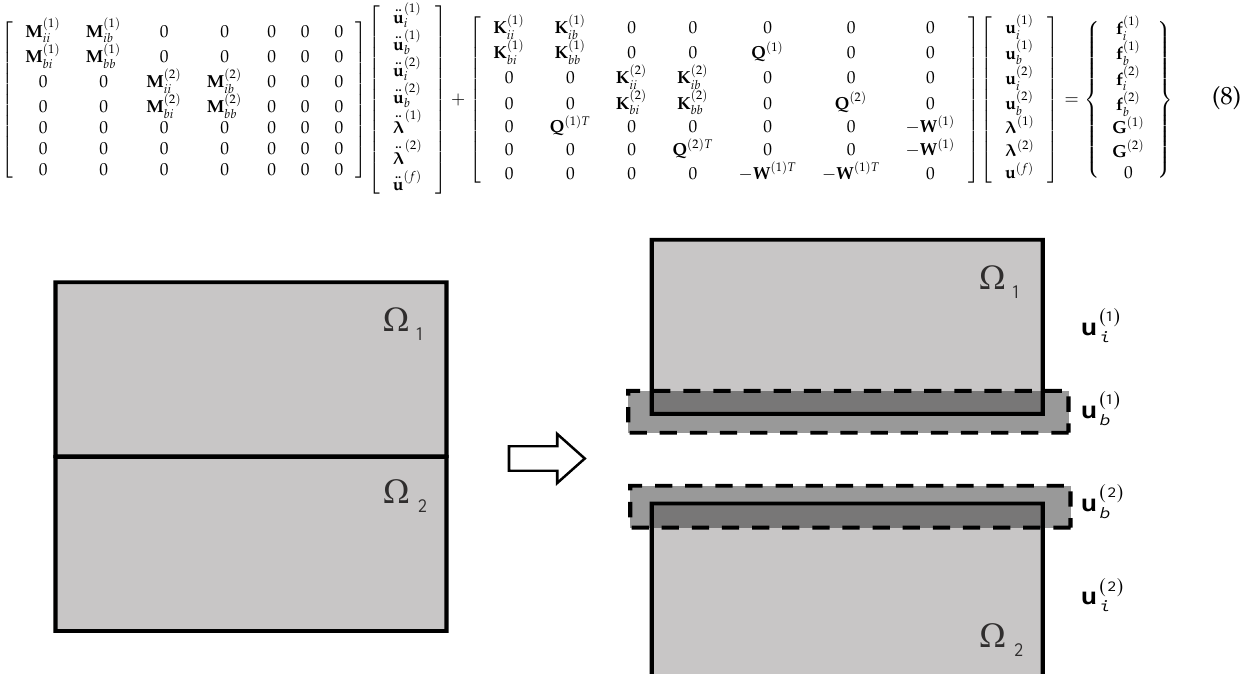
Figure 4. Division of the total displacements into the internal and interface components.